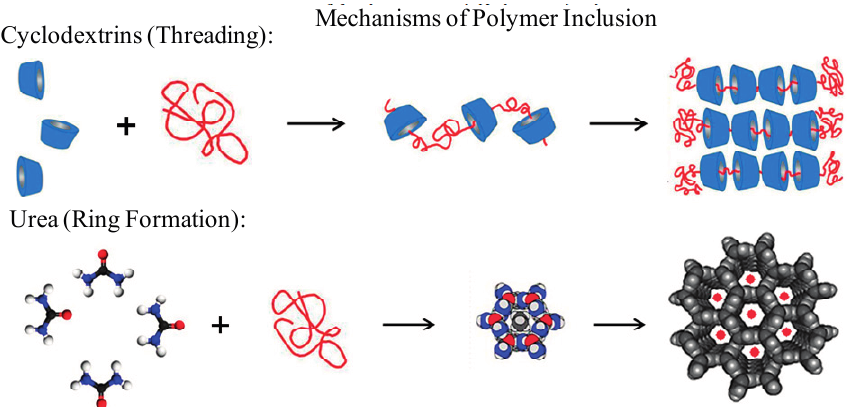
Figure 5. Mechanisms of polymer-IC formation with CD and U hosts [32].